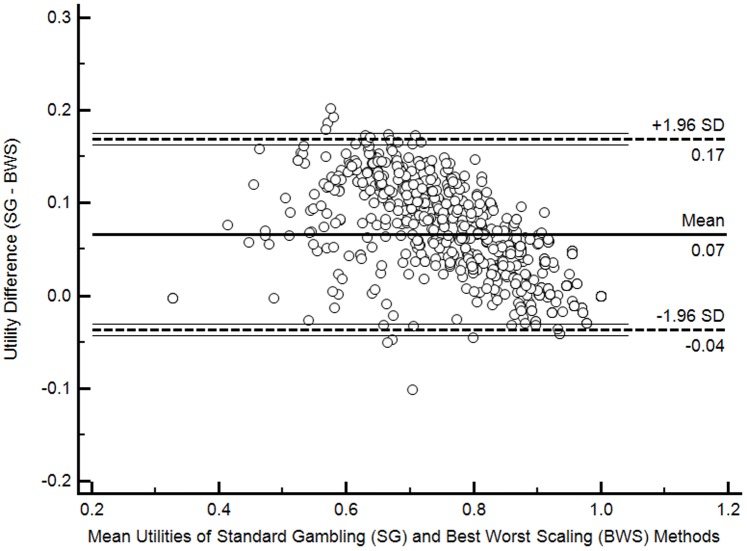
Bland-Altman plot of differences in Child Health Utility 9D (CHU9D) utilities from two scoring methods.